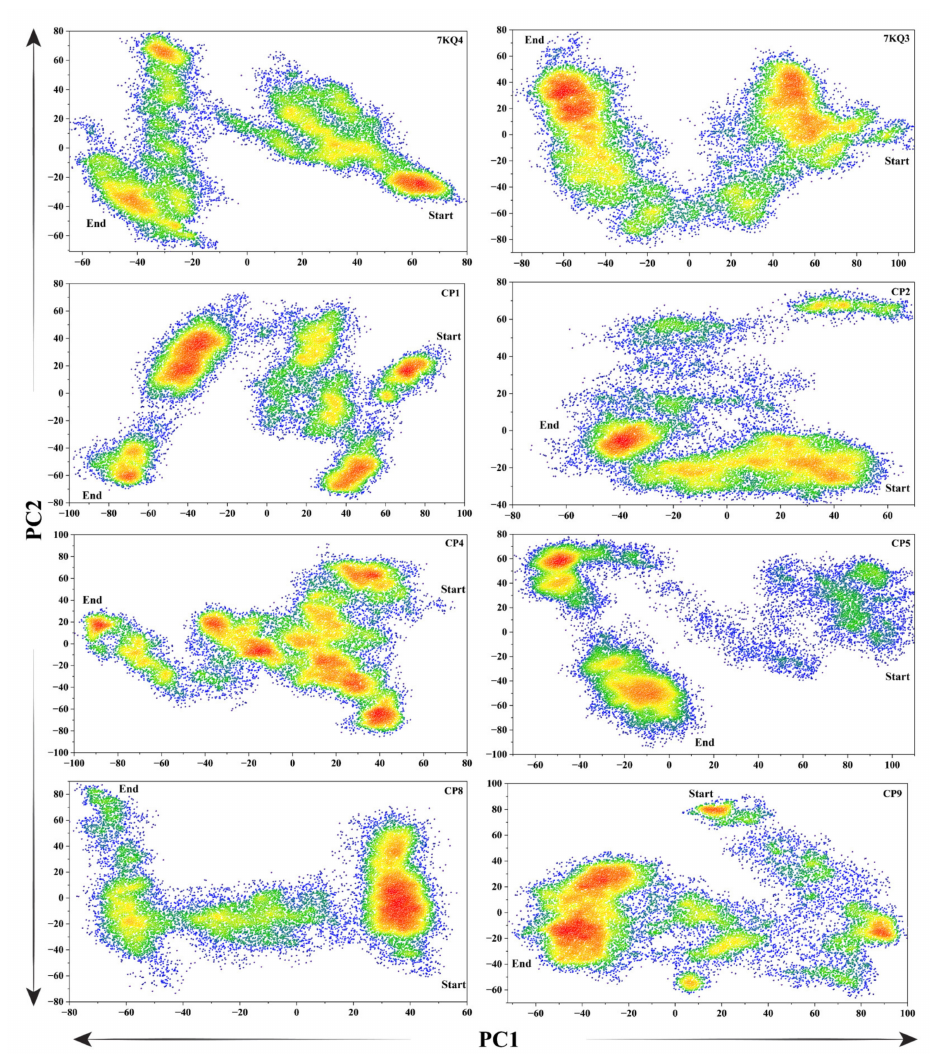
Figure 6. The principal component analysis of Isla in apo–Isla (7KQ4), substrate–Isla complex (7KQ3), and inhibitors bound states. The first principal component (PC1) and the second principal component (PC2) are plotted at x-axis and y-axis,